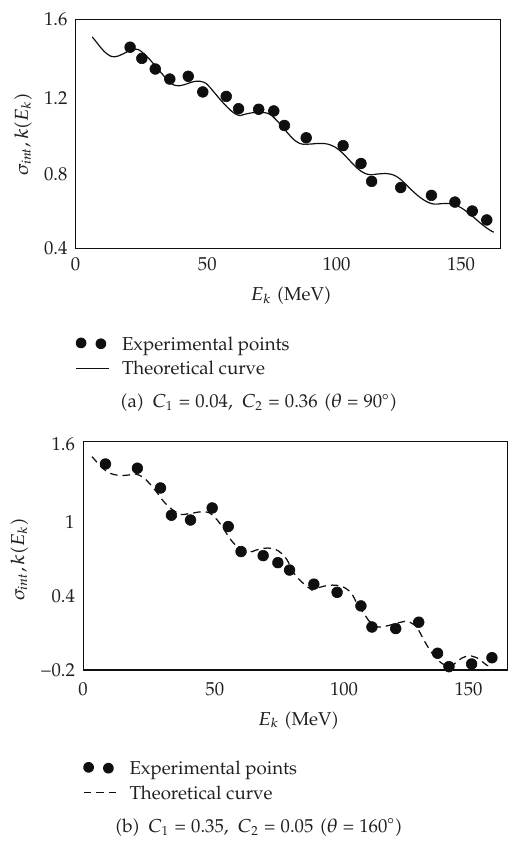
Figure 16: Inclusive process p (cid:8) 12 C → 7 Be (cid:2) 2.1GeV protons (cid:3)